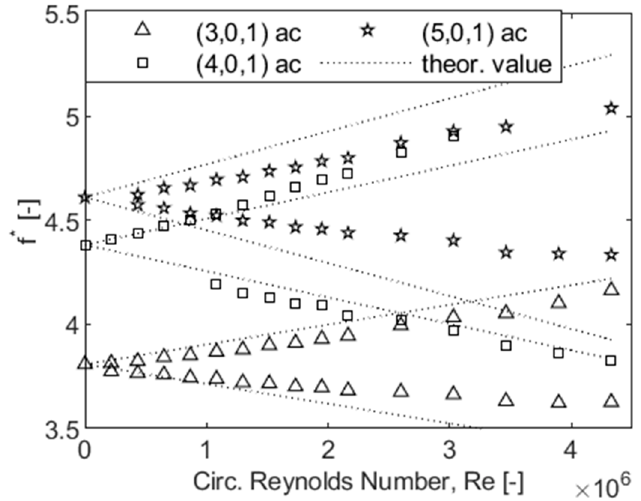
Figure 9. Normalized natural frequencies of acoustic dominant modes in air at 0.1MPa for ”slim cavity” over circumferential Reynolds number. Experimental and theoretical results.